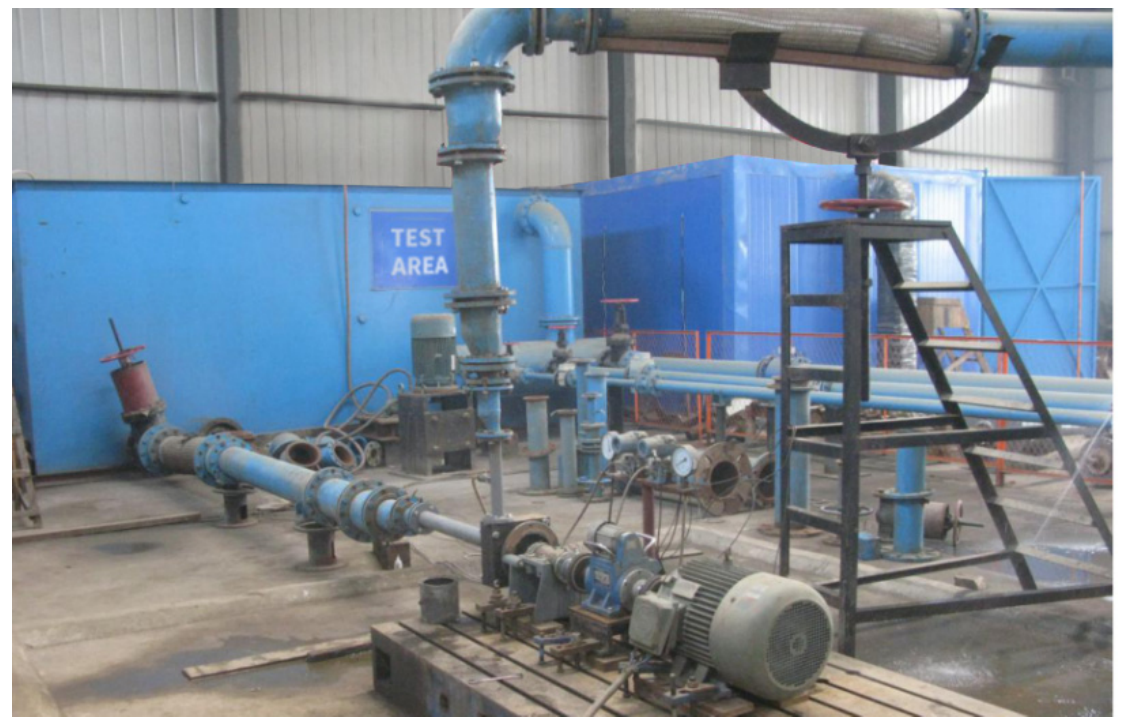
Figure 17. Hydraulic performance test